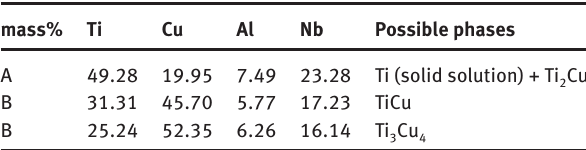
Table 2: Chemical analysis results of joints produced at 1223 K × 1 min mass%